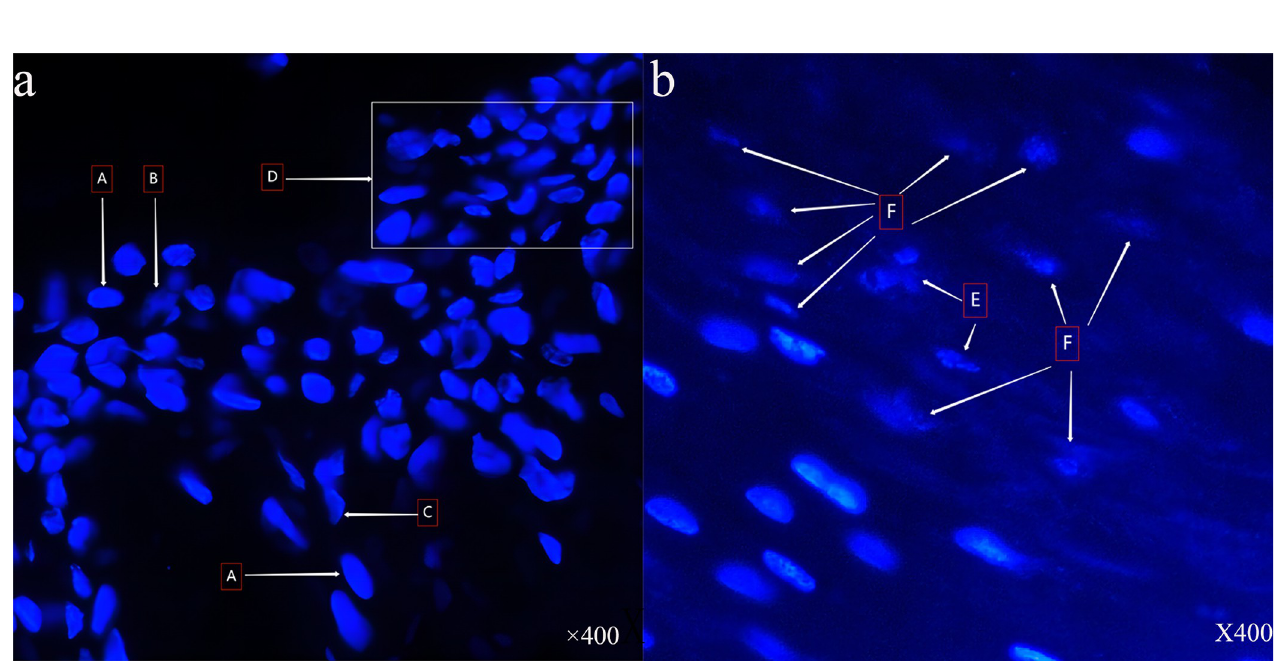
Fig 4. A. Pathological section staining of the patient’s wound in the control group (the microscopy magnification: 400X); A shows normal cells with nuclear staining morphology, B shows cells with fragmented nuclei, C shows cells with lobulated nucleus and D shows cells with irregularly polymorphic nuclei. Fig 4B. Pathological section staining of the patient’s wound in the experimental group (the microscopy magnification: 400X); E shows cells with lobulated nucleus and F shows the cells with blurred edges nucleus.